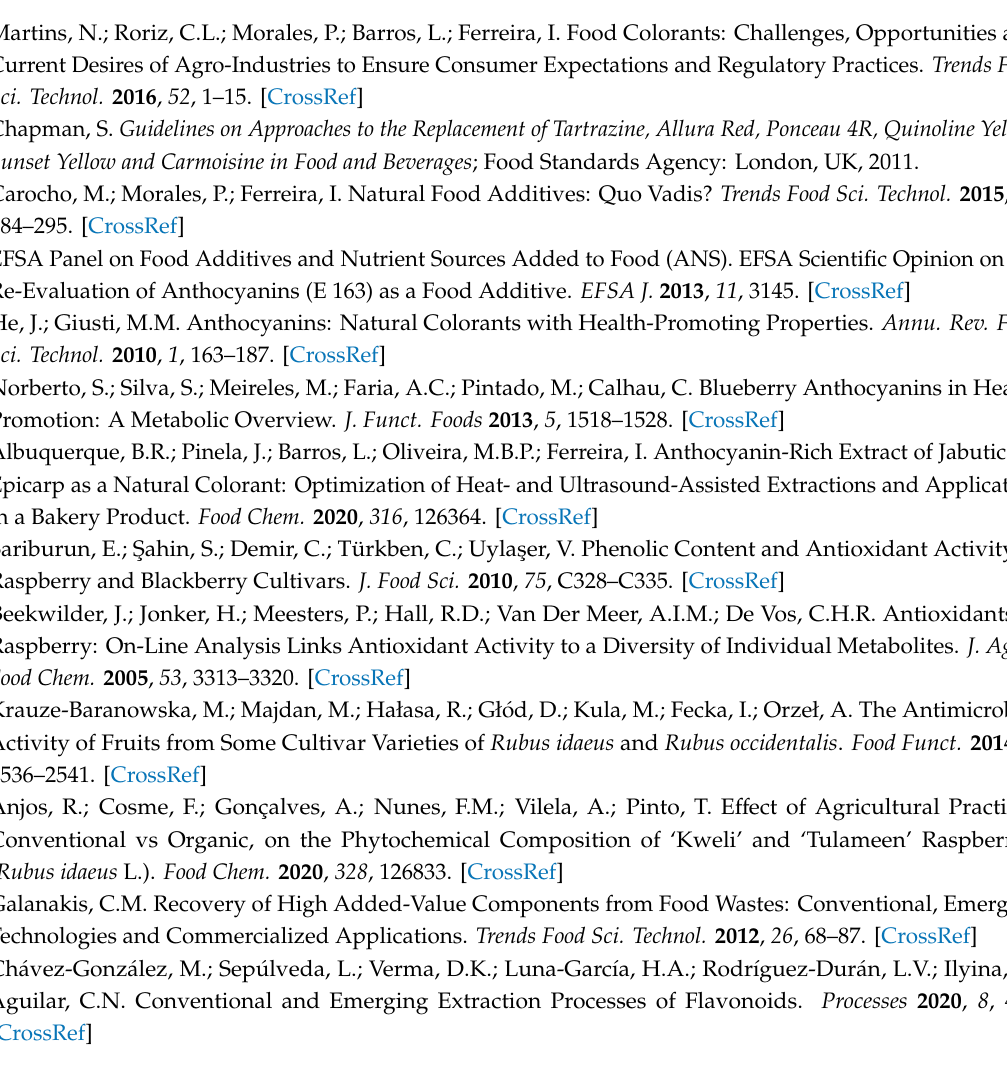
(Table 2), Table S1: Parametric values of the polynomial equations and statistical information of the model fitting procedure for both extraction processes. Parametric superscripted 1–3 stand for the variables time ( t ), temperature or ultrasonic power ( T or P ), and solvent ( S ),